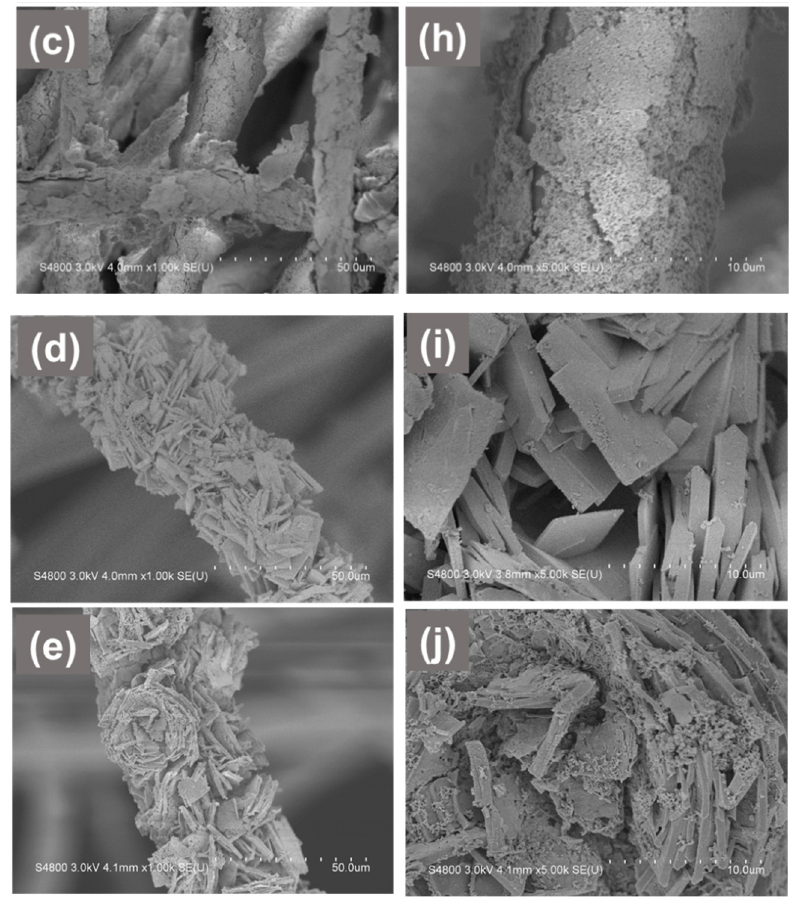
Figure 2. Field-emission scanning electron microscopy (FESEM) images of ( a , f ) gauze ( b , g ) G/PDA ( c , h ) G/PDA/BWNp ( d , i ) G/BWP ( e , j ) G/BWP/PDA.